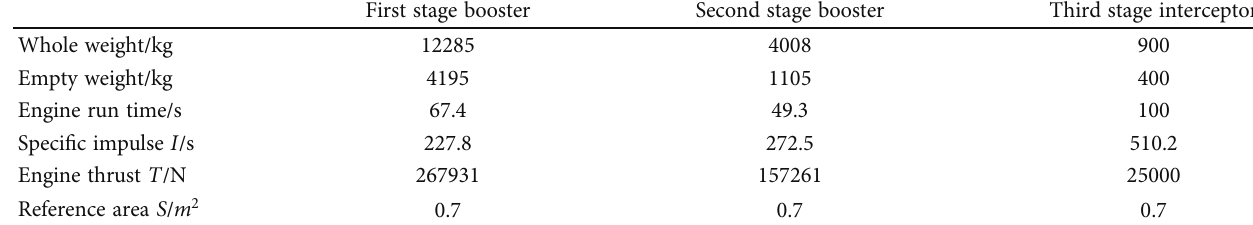
Table 1: Overall parameters of interceptor.